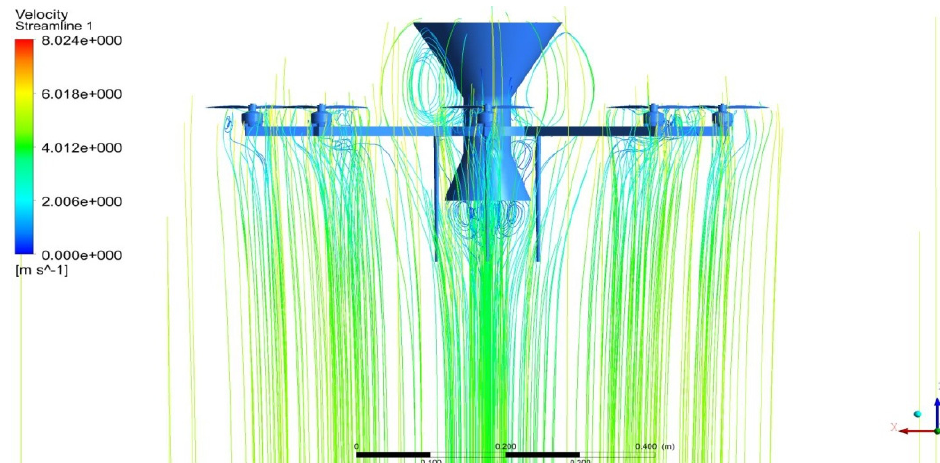
Figure 24. Aerostatic velocity variations over the octocopter in foggy conditions.